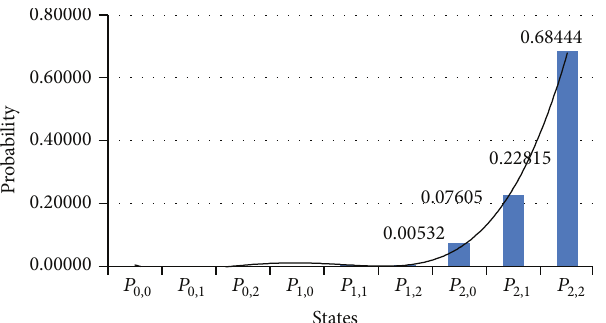
Figure 6: Fixed-path example with nonoverlapping